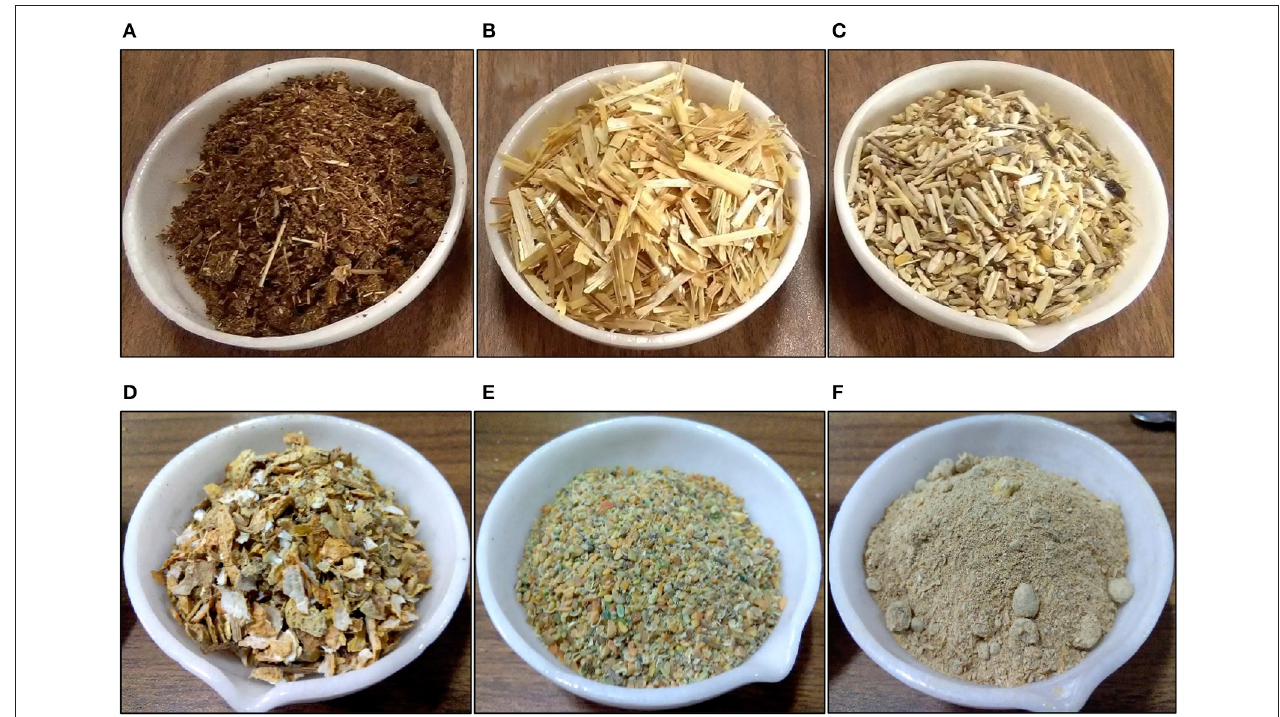
FIGURE 2 | Substrates. (A) Organic fraction of MSW, (B) Wheat straw, (C) Mung bean husk, (D) Groundnut shell, (E) Guar husk and (F) Rice bran.